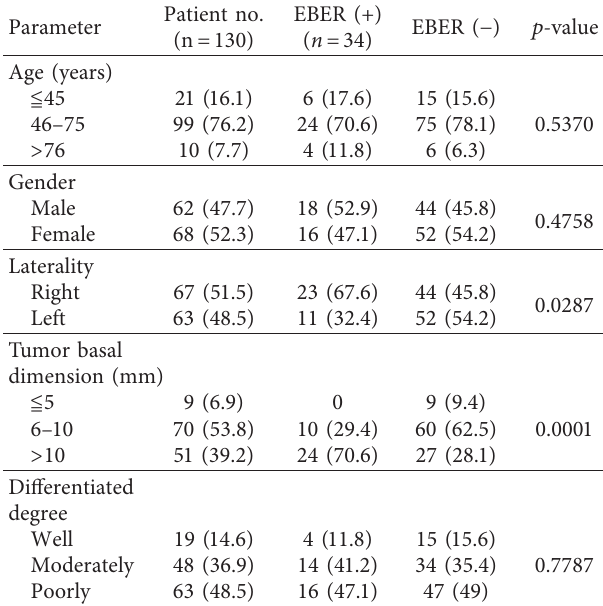
Table 3: Association of EBV reactivity with clinicopathological